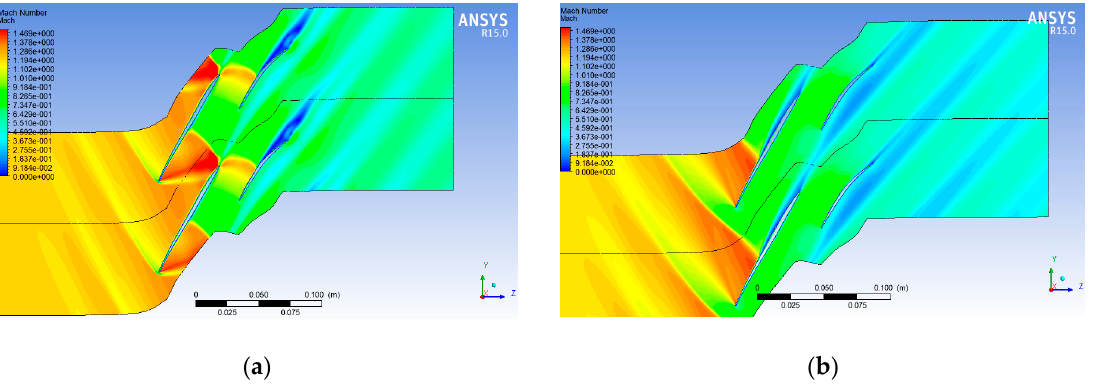
Figure 6. The Mach contour plots at inlet Mach number 1.2. NS: Near Stall. ( a ) at the DE point, ( b ) at the NS point.